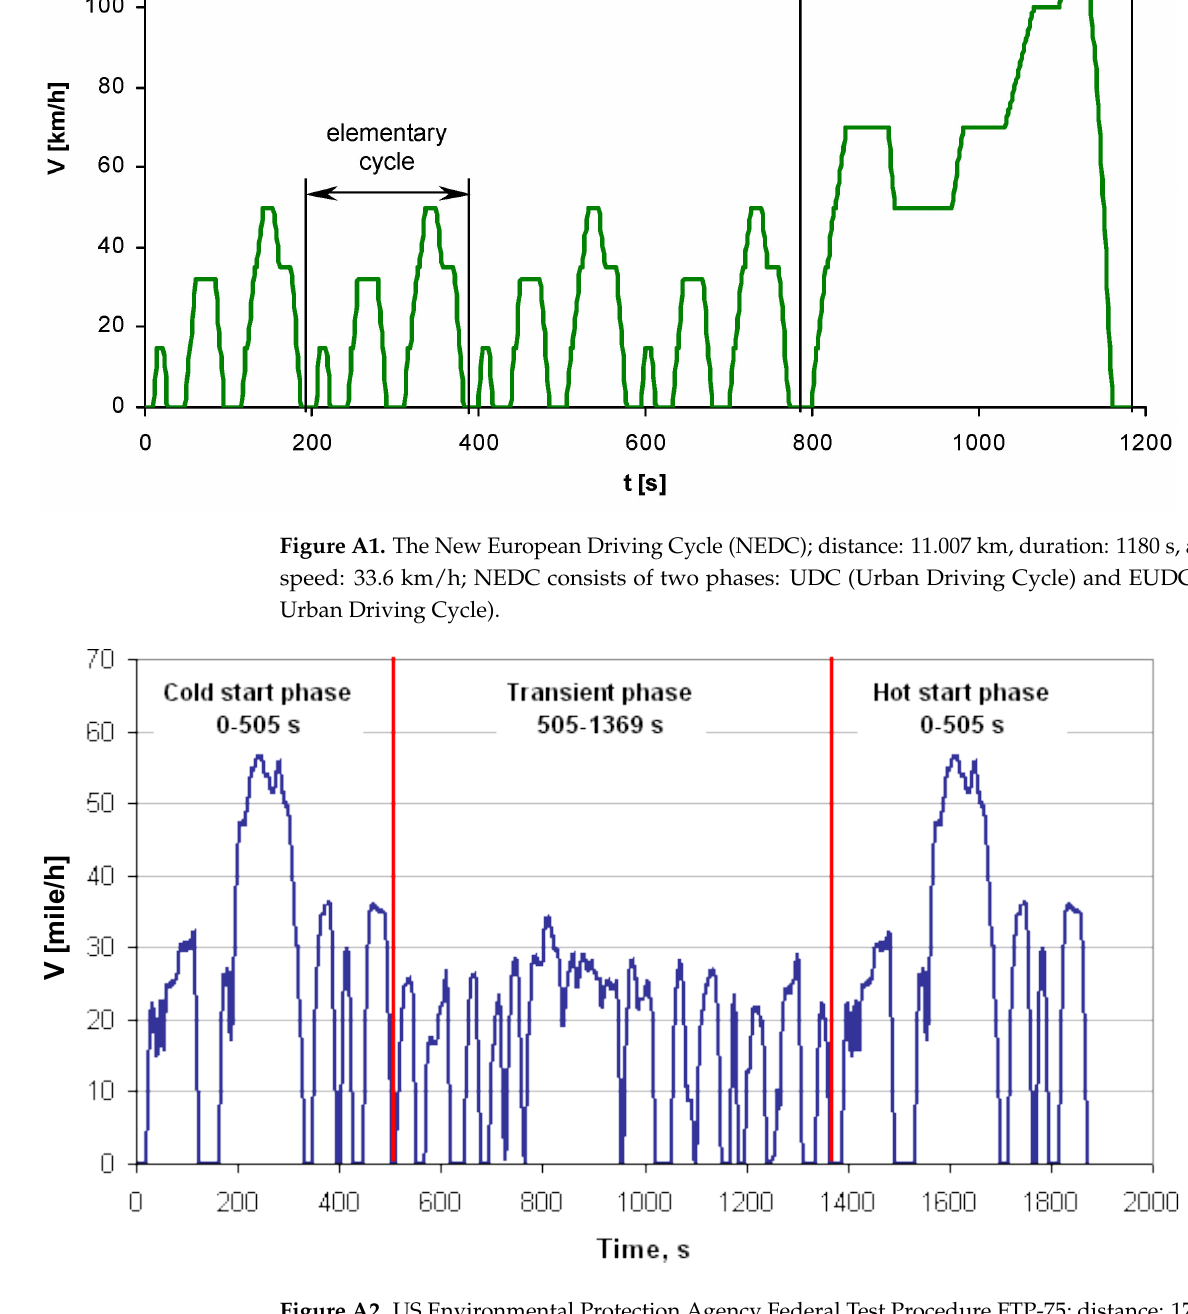
Figure A2. US Environmental Protection Agency Federal Test Procedure FTP-75; distance: 17.77 km, duration: 1874 s, average speed: 43.1 km/h; FTP-75 consists of three phases: cold start phase, transient phase and hot start phase.